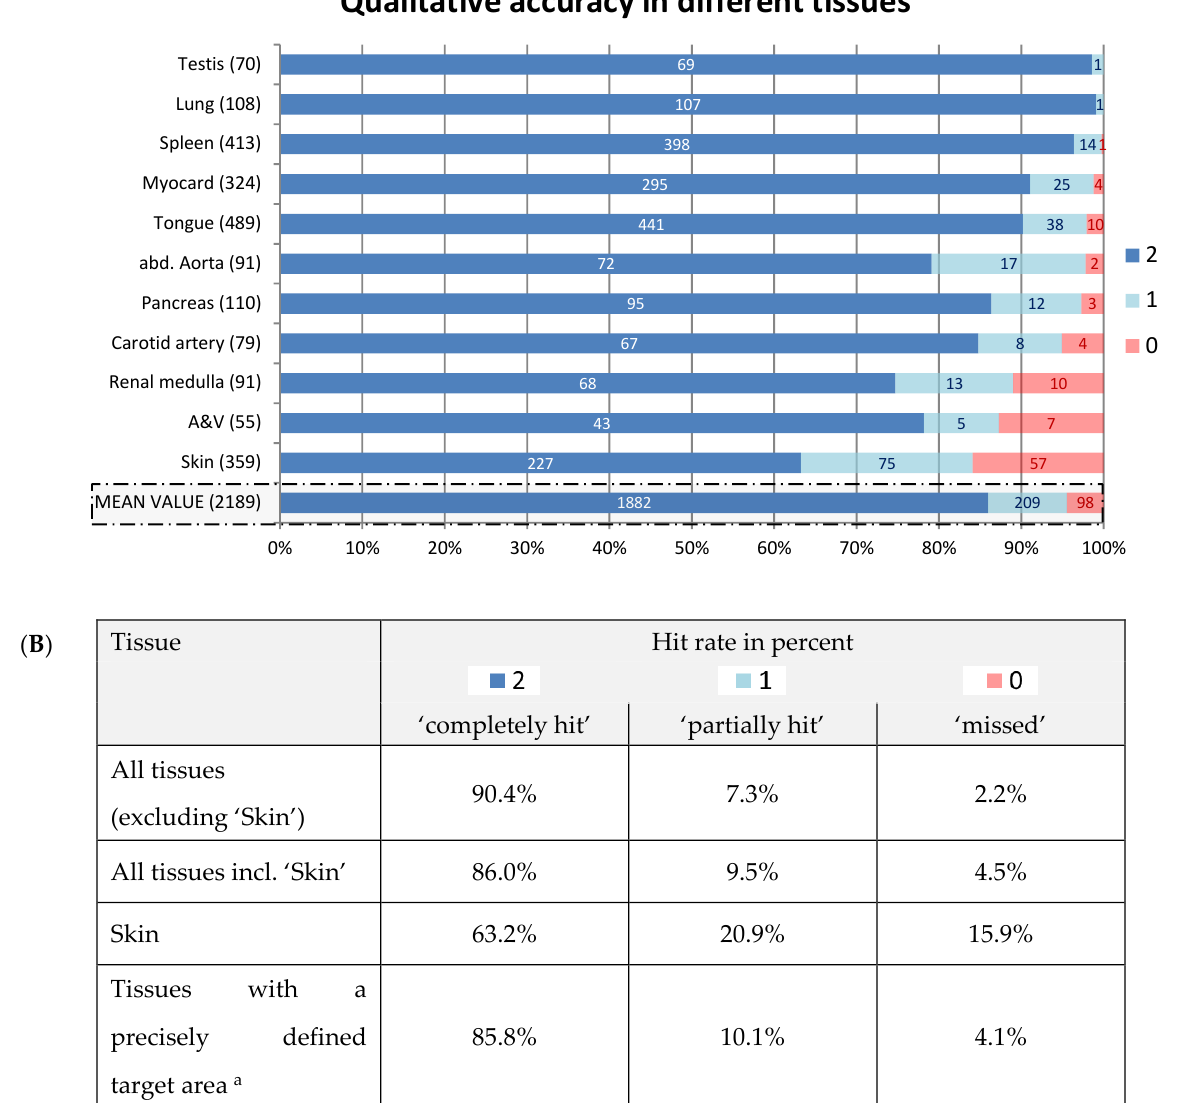
Figure 8. Qualitative Accuracy in different tissues. ( A ) The diagram shows different soft tissues depending on the qualitative punching accuracy in correlation to the punch specification. The numbers 2, 1 and 0 in the legend stand for ‘completely hit’, ‘partially hit’ or ‘missed’ punch specifications. The bar labelling denotes the respective number of punch cores. The bar width shows the percentage of cores. ( B ) Overview of the main results presented in ( A ) to investigate qualitative accuracy.